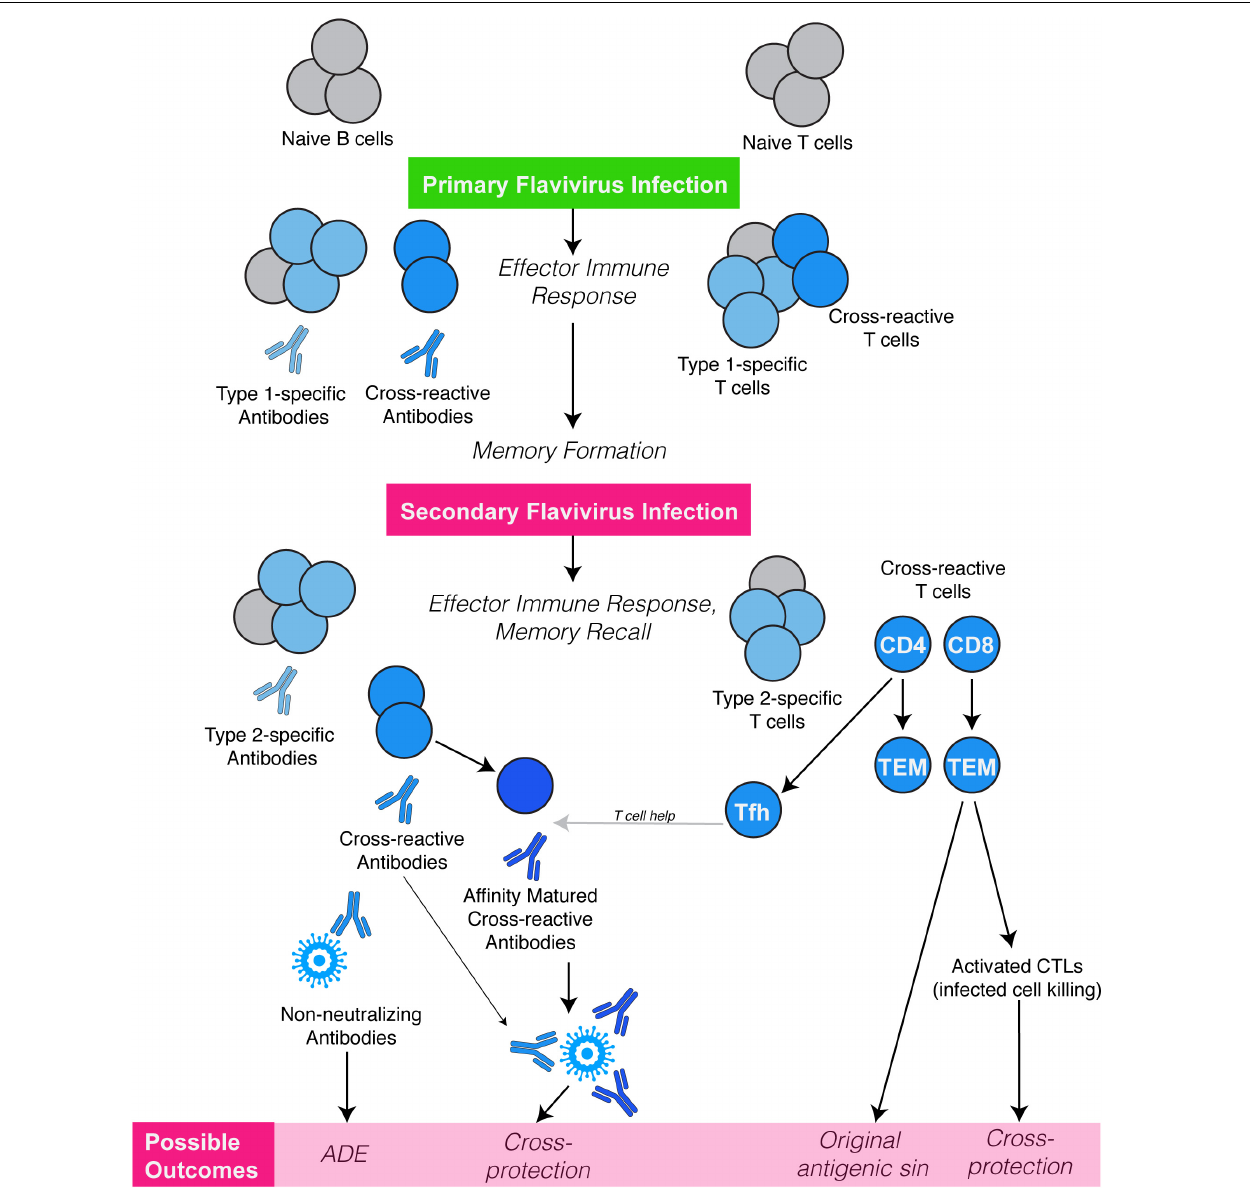
FIGURE 2 | Flavivirus cross-reactive cellular immune responses. Infection or vaccination against a flavivirus (Type-1) results in a primary immune response dominated by generation of Type-specific antibodies and T cell responses, followed by a memory formation. Owing to their antigenic relatedness, flavivirus cross-reactive antibodies and T cells (CD4 & CD8) are also generated. A secondary challenge with a second flavivirus (Type-2) can potentially reactivate cross-reactive memory T cells, those, which have higher specificity for Type-1 than for Type-2 flavivirus. These weakly cross-reactive memory T cells may outcompete naive T cells that would be more specific for Type-2, resulting in T cell original antigenic sin. However, memory T cells could also provide cross-protection directly by acquiring CTL function resulting in enhanced killing of virus-infected cells. Importantly cross-reactive CD4 Tfh cells can be recalled in the lymph node germinal centers, providing help to B cells, and improving both affinity and avidity of antibodies that are cross-reactive and neutralizing. Flavivirus cross-reactive antibodies also interact in different ways during a secondary flavivirus infection. After primary infection, high affinity and Type-specific antibodies are produced, which can neutralize virus when present at optimal concentrations. However, during secondary heterologous flavivirus infection, pre-existing cross-reactive, sub-neutralizing antibodies may lead to opsonization of virus particles and enhanced uptake by various immune cells such as monocytes via Fc receptors, resulting in increased virus replication, a phenomenon termed antibody-dependent enhancement